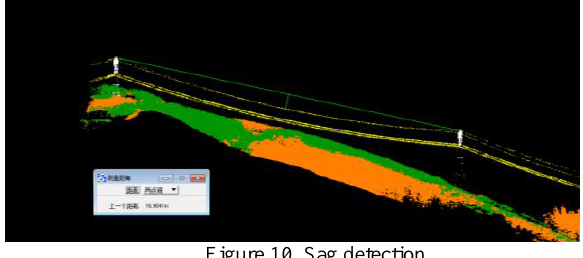
Figure 10. Sag detection